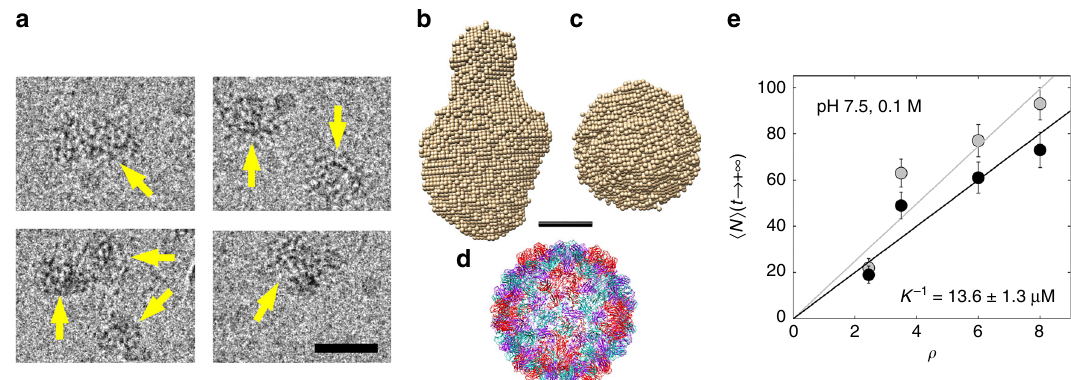
Fig. 2 NPCs at equilibrium. a Cryo-TEM images of NPCs (yellow arrows) obtained in the same conditions as in Fig. 1b after a few days of incubation. Scale bar is 30 nm. b Side and c , top views of an ab initio reconstruction of NPCs calculated from the last scattering pattern of the experiment shown in Fig. 1b. d Crystal structure of the native capsid shown for comparison (PDB reference 1ZA7). Scale bar is 10 nm. e N h i obtained near equilibrium for various mass ratios and evaluated from the forward scattering intensities either by using the templated assembly model (black discs) or by computing N h i discs; see Supplementary Fig. 7 for the time traces). The black and light gray lines are linear fi ts of N h i obtained by the templated assembly model and N h i , respectively. The critical concentration K − 1 is estimated from the slope of the black line. Error bars are de fi ned as s.e.m. and were obtained by up propagating the standard deviations of photon counts (see